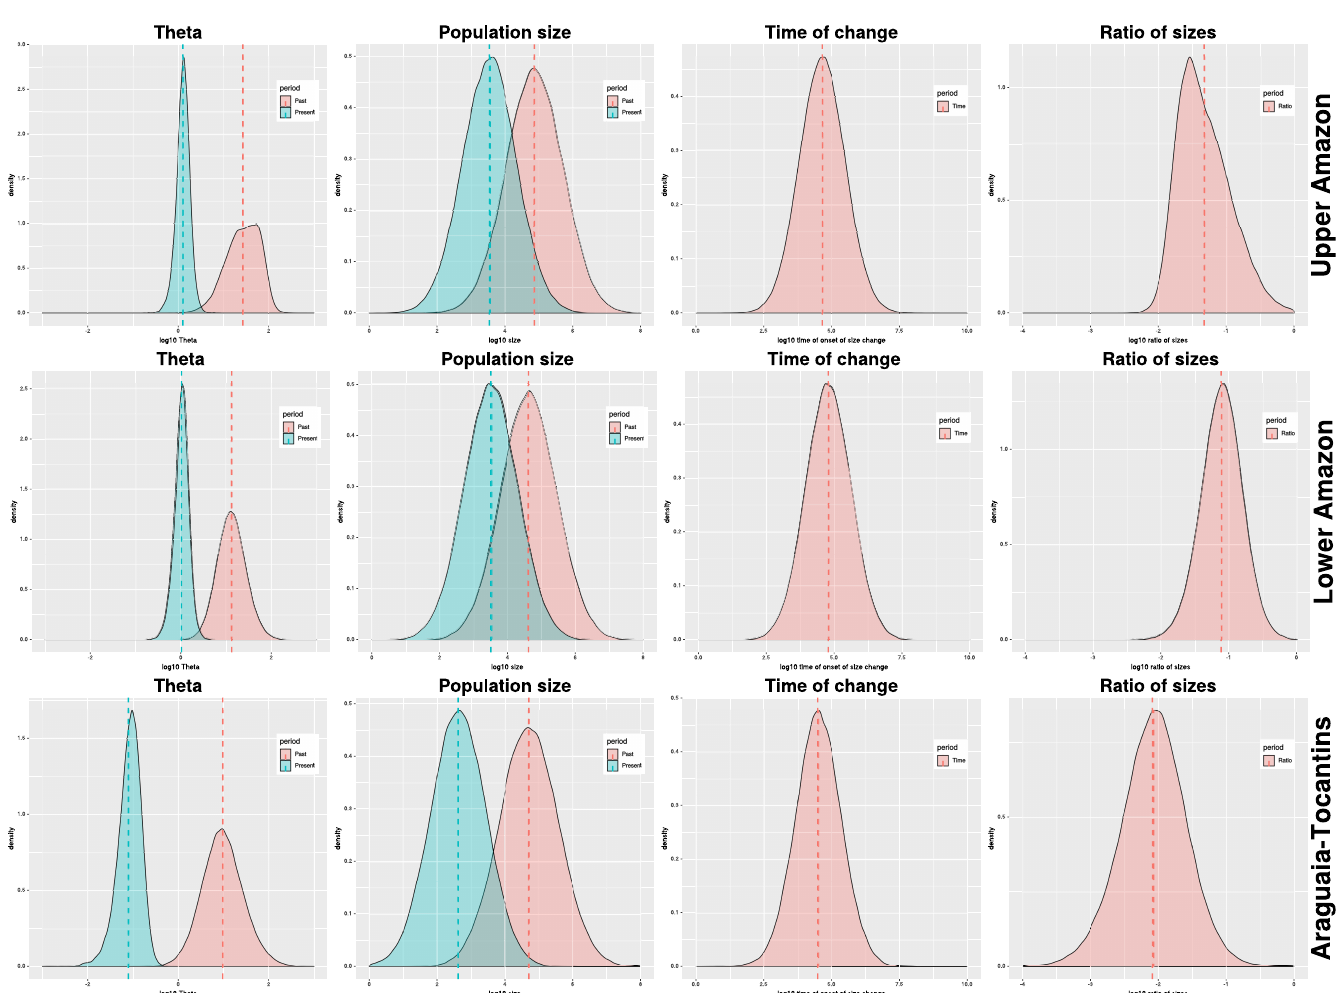
Fig 7. Coalescent population size change, Araguaia-Tocantins vs. lower Amazon vs. upper Amazon. Note: all metrics are log10 scale. Theta–historical and current theta (4 Neμ ); Population size–historical and current effective population size ( Ne ); Time of change–onset of population size change from historical to current theta; Ratio of sizes–ratio of current to historical